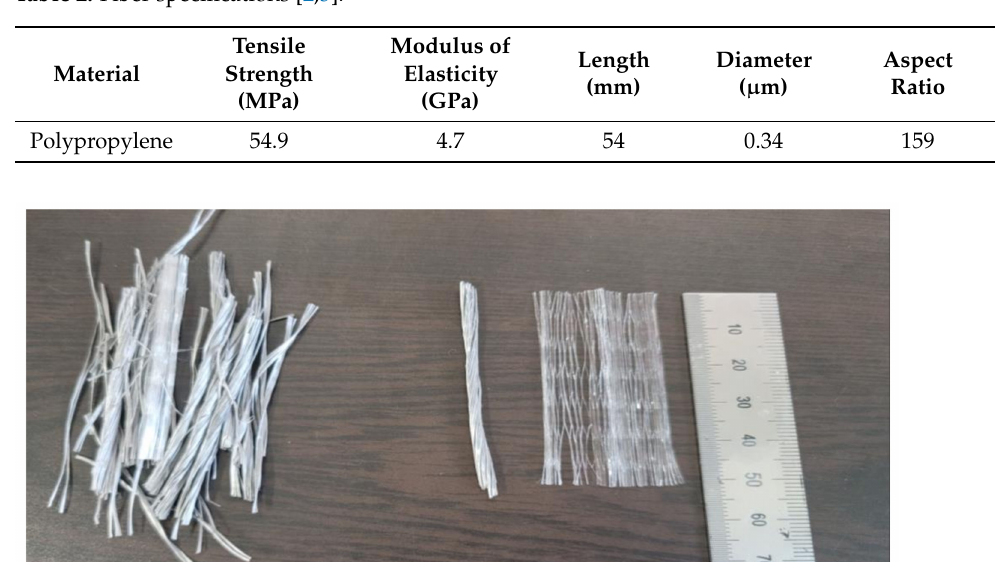
Figure 3. Macro-synthetic fiber [2].